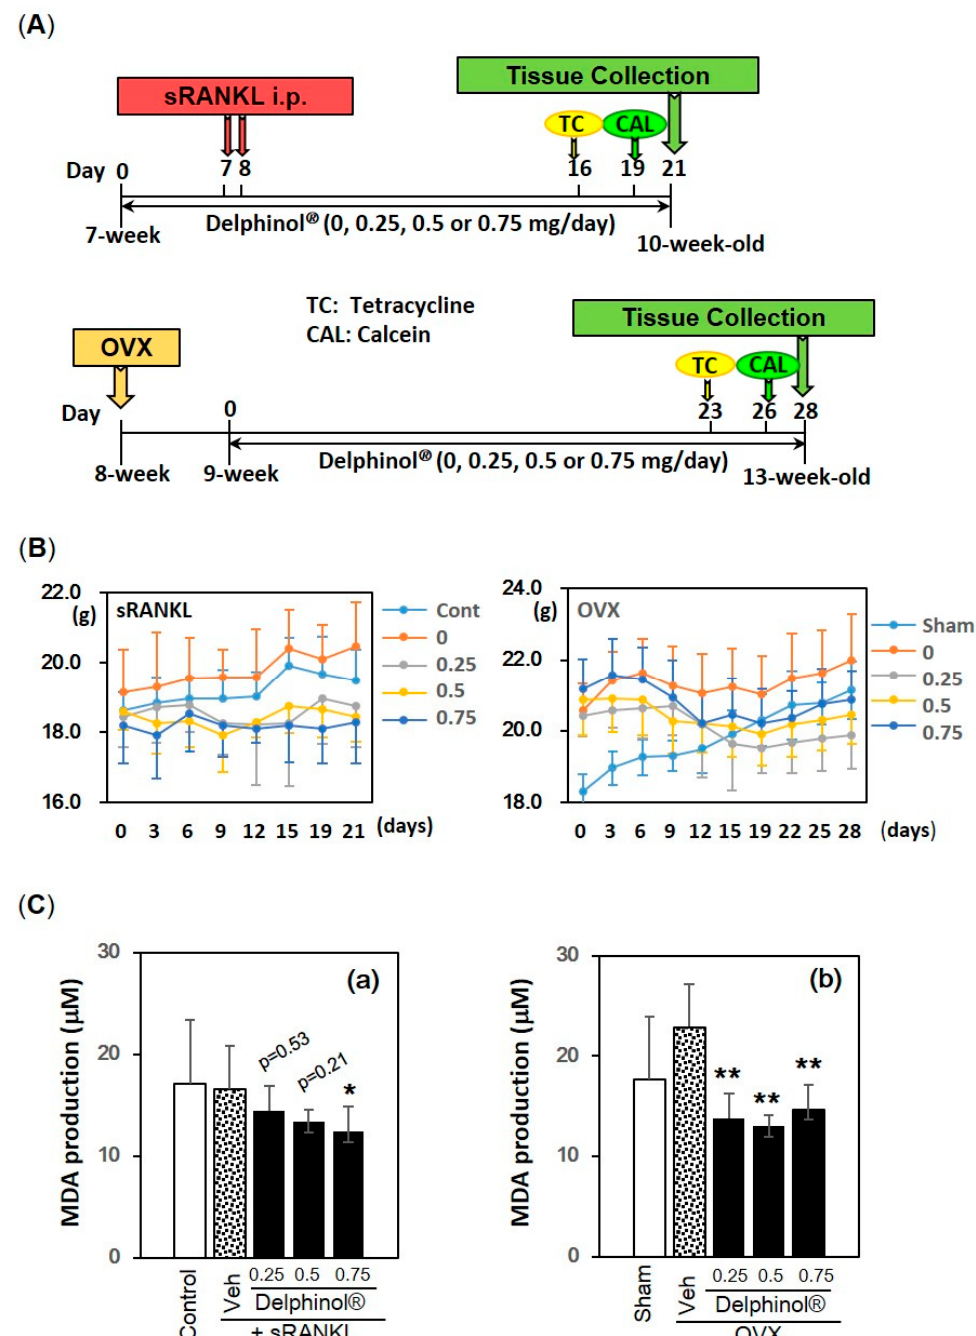
Figure 5. In vivo experimental protocol and effects of Delphinol ® on body weight and plasma malondialdehyde (MDA) level. ( A ) Experimental protocol of sRANKL-induced (upper panel) and ovariectomized (OVX) (lower panel)-induced osteopenic mouse models. All mice were injected with two fluorescent molecules, tetracycline and calcein, sequentially prior to sacrifice for the purpose of kinetic analyses in bone histomorphometry. ( B ) Changes in body weight during the experiment. ( C ) Plasma MDA levels in sRANKL-induced ( a ) and OVX ( b )-induced osteopenic mice. Values are expressed as mean ± SD ( n = 5–8). p values and significance levels are the comparisons between vehicle-treated and MBE-treated groups. * p < 0.05, ** p < 0.01. As depicted in the images generated from micro-CT scans of the vertical midsection of metaphyseal femurs of sRANKL-induced (Figure 6A), and OVX-induced (Figure 6C) osteopenia, the area vacant of trabecular bone (seen in the vehicle group) decreased in size and filled with trabecular